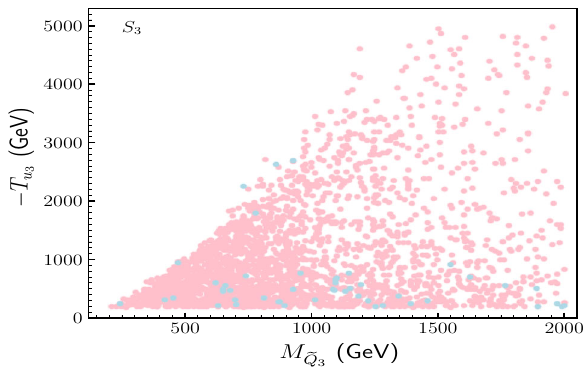
Fig. 13 Viable points of the parameter space for S 3 in the − T u m (cid:6) Q 3 L plane. The color code is the same as in Fig. 12